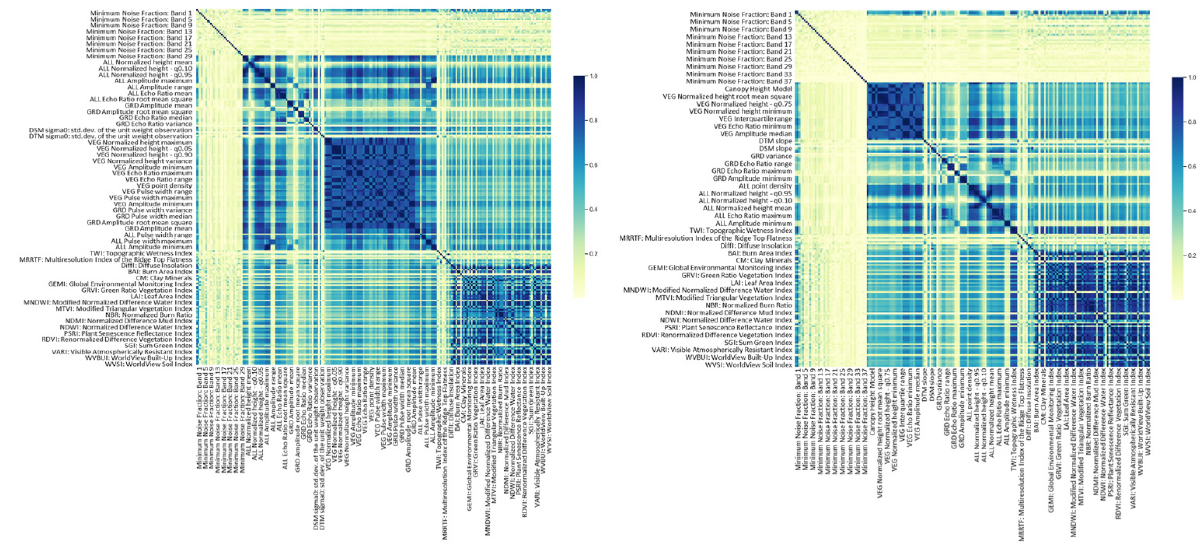
Figure 11. An example of Spearman’s correlation matrix for data acquired in summer in the UB area.